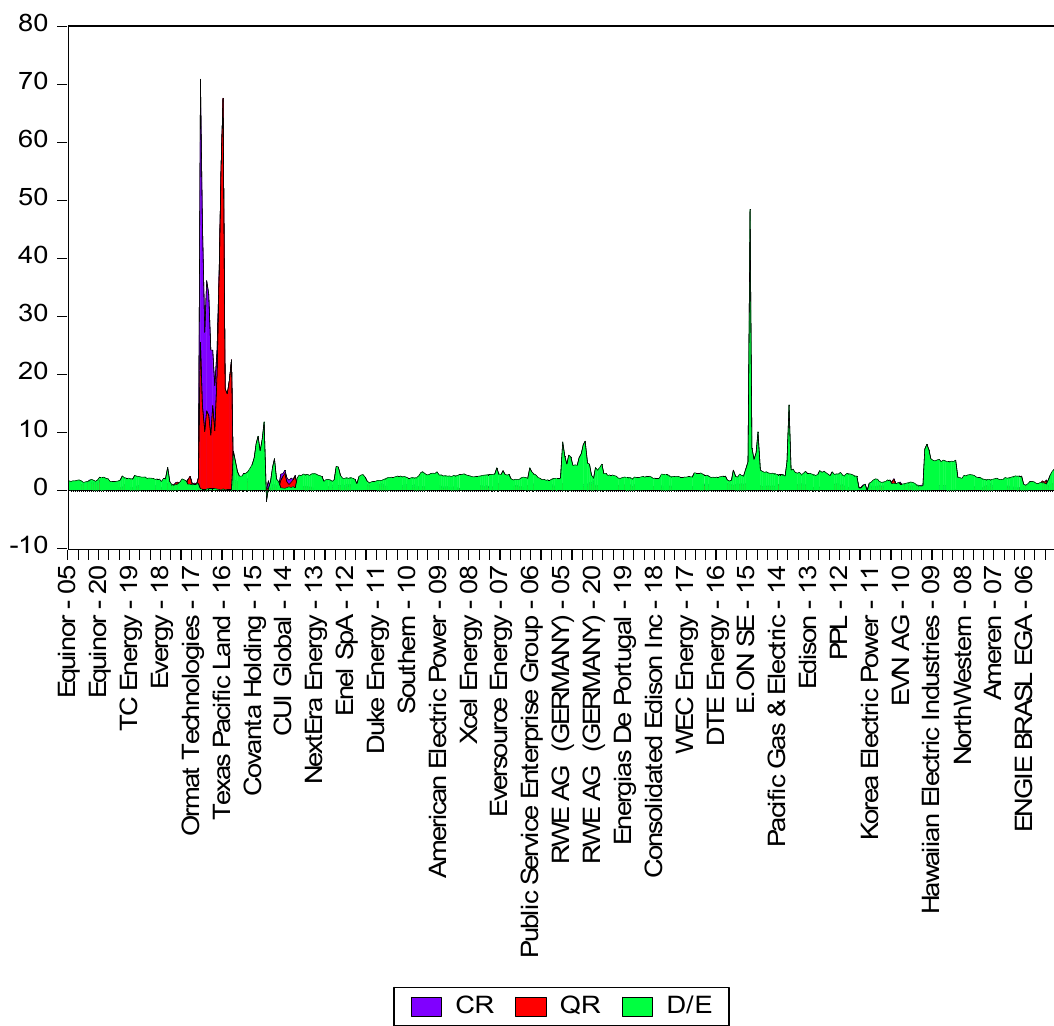
Figure 1. Evolution of equilibrium indicators for electricity companies. Note: The symbol CR denotes the current liquidity ratio, QR denotes the quick ratio, and D/E denotes the debt to equity ratio.